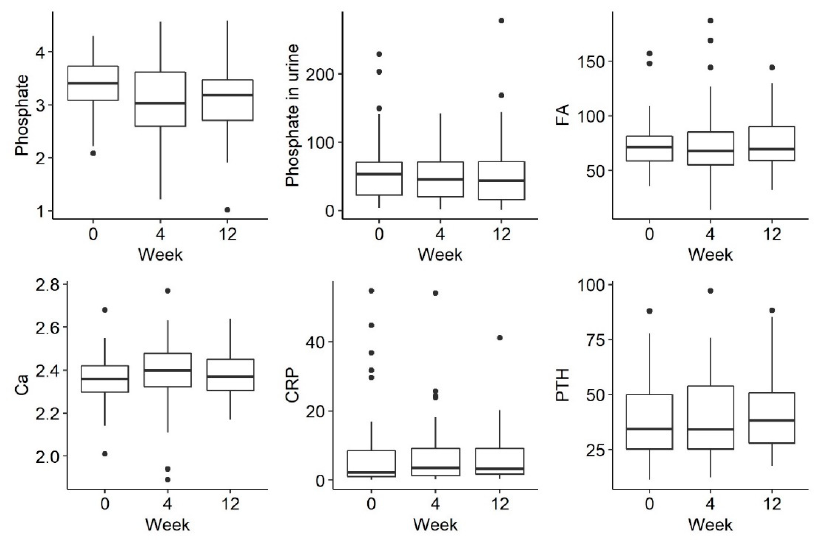
Figure 2. Changes in the concentration of phosphate, phosphate in urine, FA (alkaline phosphatase), Ca (calcium), CRP (C-reactive protein) and PTH (parathyroid hormone) before iron administration and 4 weeks and 12 weeks after administration.